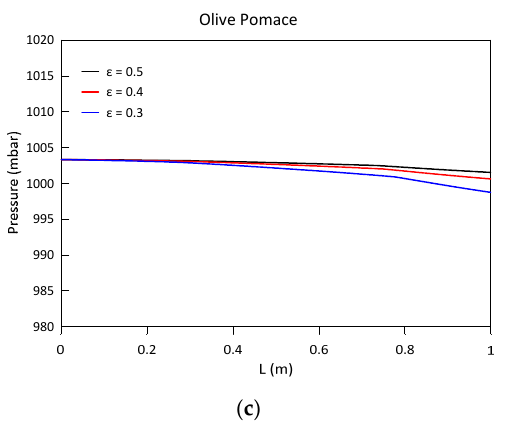
Figure 14. Pressure evolution along the reactor axis at different ε for ( a ) woodchip case 1, ( b ) hydro-char from green waste, ( c ) olive pomace.